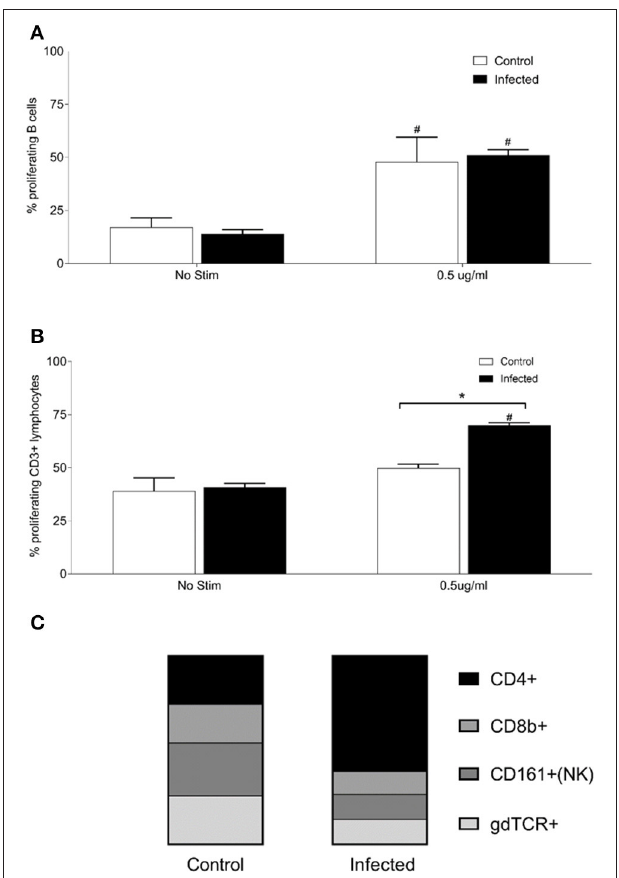
FIGURE 5 | Proliferative responses and cellular phenotypes of lymphocytes isolated from the renal lymph node of 15 infected and nine control rats. Lymphocytes were isolated from the RLN, pooled into groups of 3 animals, and stimulated with purified OM fraction from Leptospira. Percentage of proliferating B cells (CD3 − , CD19 + , or B220 + ) (A) , percentage of proliferating T cells (CD3 + ) (B) and phenotype by proportion of proliferating CD3 + cells stimulated with 0.5 µ g/ml OM antigen (C) . *Indicates statistical significance between infected and control; # Indicates statistical significance between OM antigen stimulated wells and no stimulant (No Stim) wells within the same group.